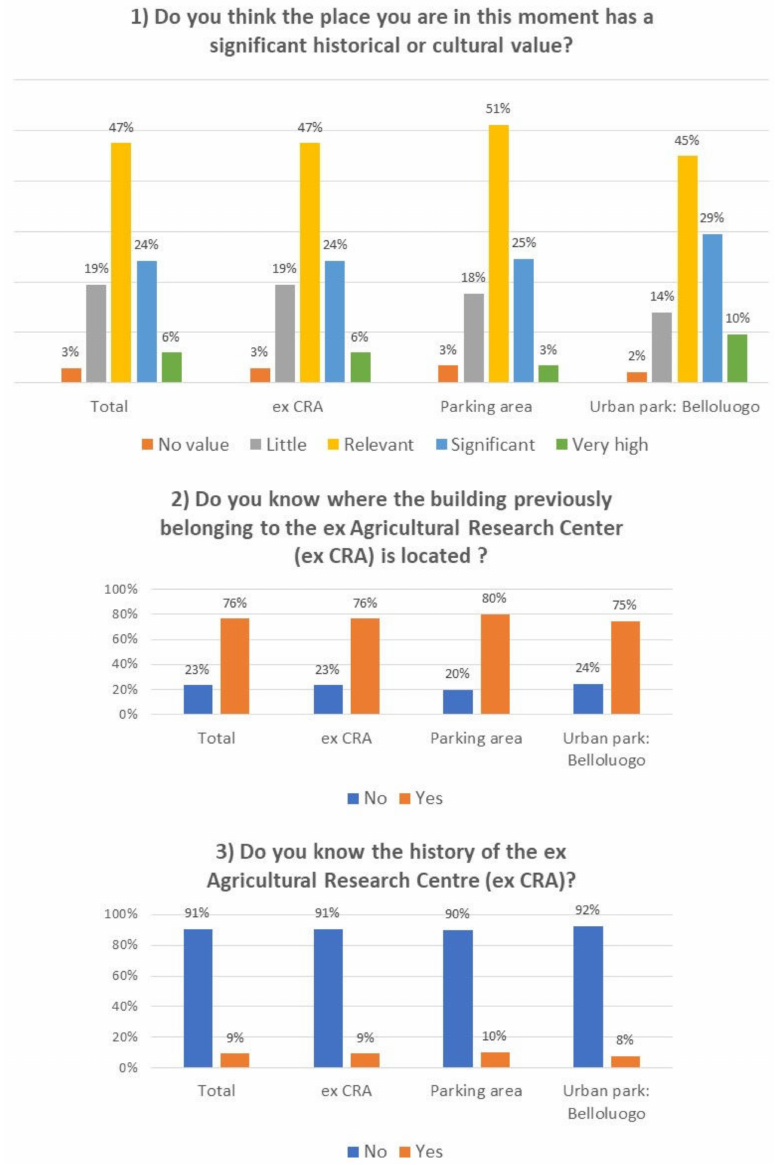
Figure 5. Answers to Questions 3, 4, and 5, concerning the historical relevance of the study